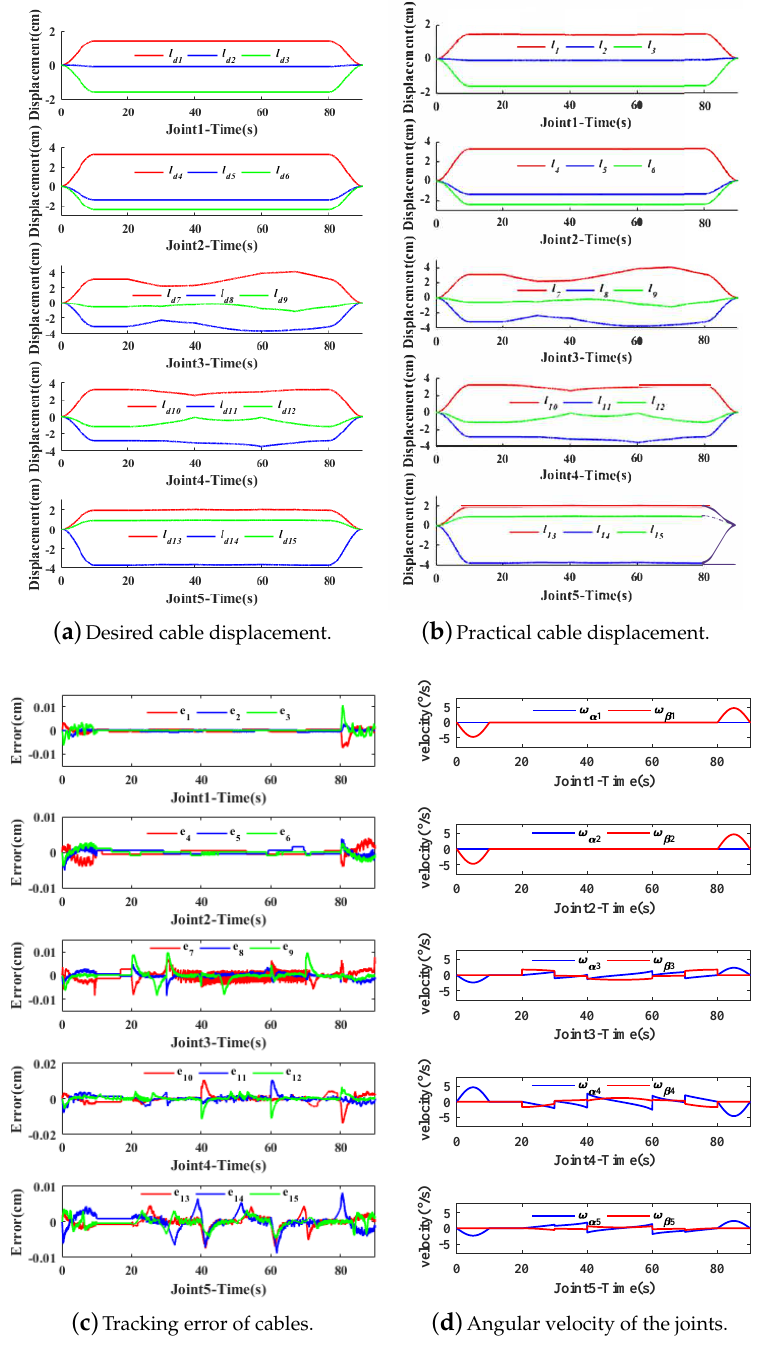
( d ) Angular velocity of the joints. Figure 14.